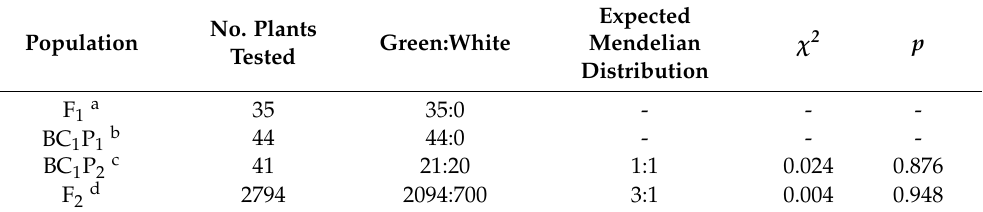
Table 1. Segregation of rind color in eggplant populations. No. Plants Population Tested